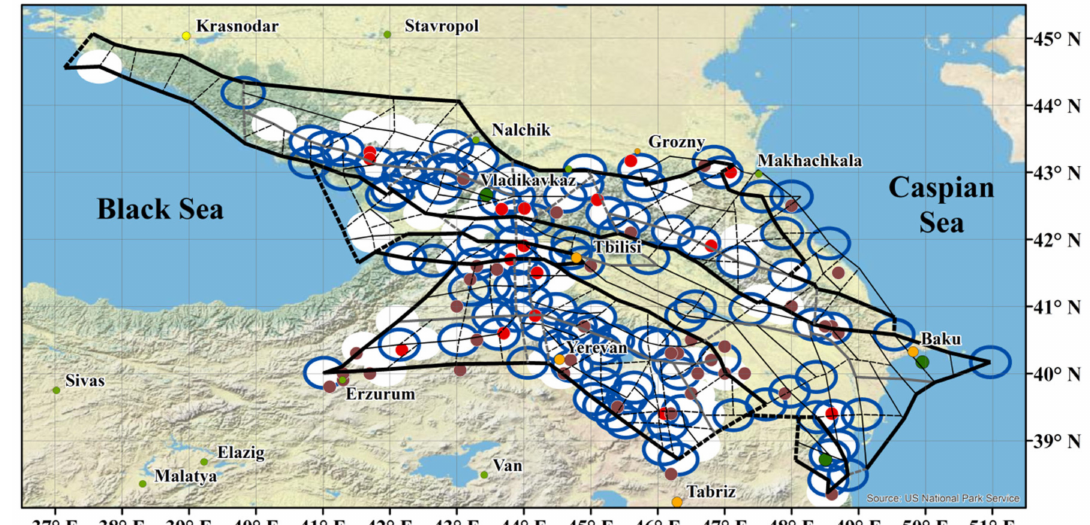
Figure 4. The morphostructural zoning map of the Caucasus (legends as in Figure 2) [40], areas prone to earthquakes with M ≥ 6.0 (ellipses with blue boundaries—Barrier-3 [17], white ellipses—Cora-3 [41], white ellipses with blue boundaries— both algorithms) and the epicenters of earthquakes with M ≥ 6.0 (brown circles—before 1900, red circles—in the period from 1900 to 1992 (used to form the learning set B 0 ), dark green circles—since 1993 (material for a pure exam)) [42].